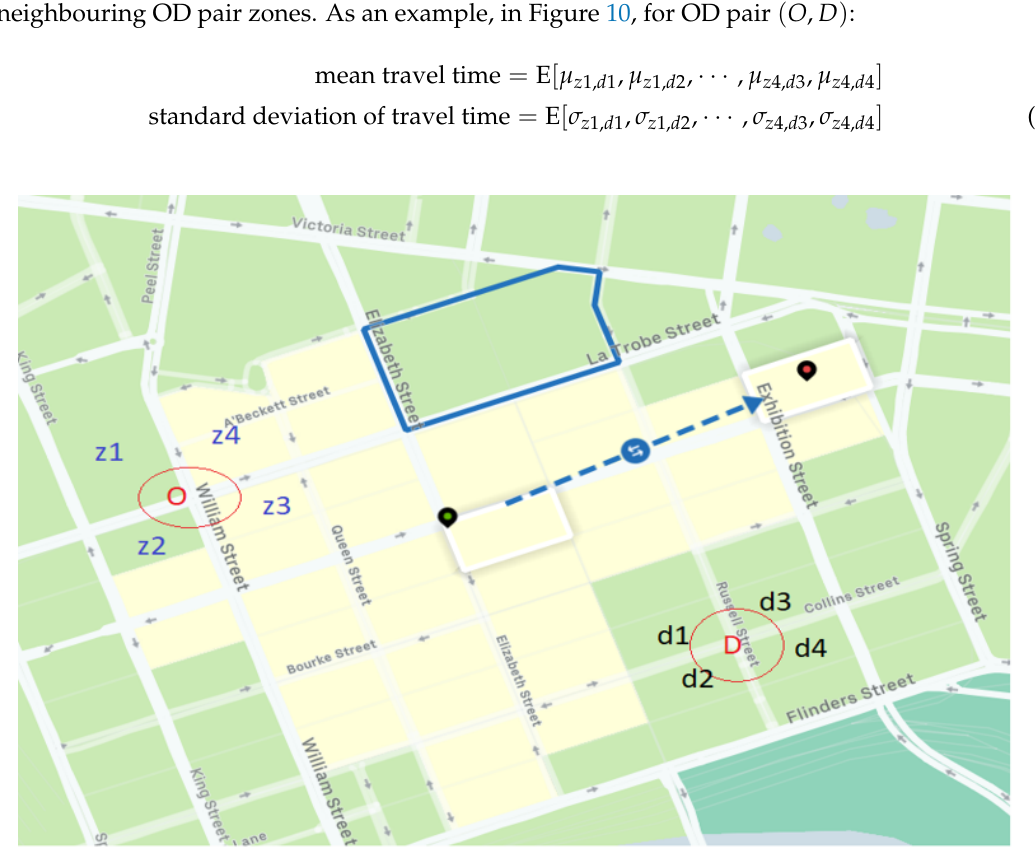
Figure 10. A screenshot from Uber movement data with an overlaid illustration of zonal travel times